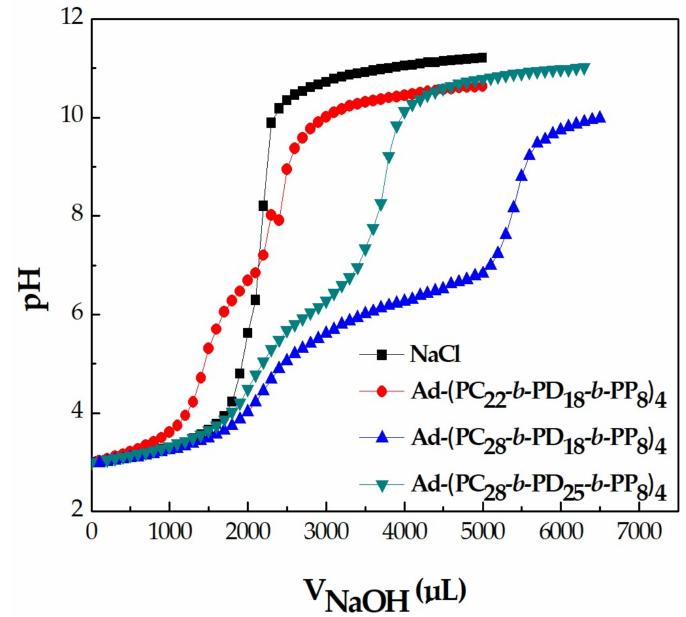
Figure 4. The pH-profile of Ad-(PCL- b -PDEAEMA- b -PPEGMA) 4 (1 mg/mL)and NaCl (1 mg/mL) by acid–base titration with 0.2 M HCl and 0.1 M